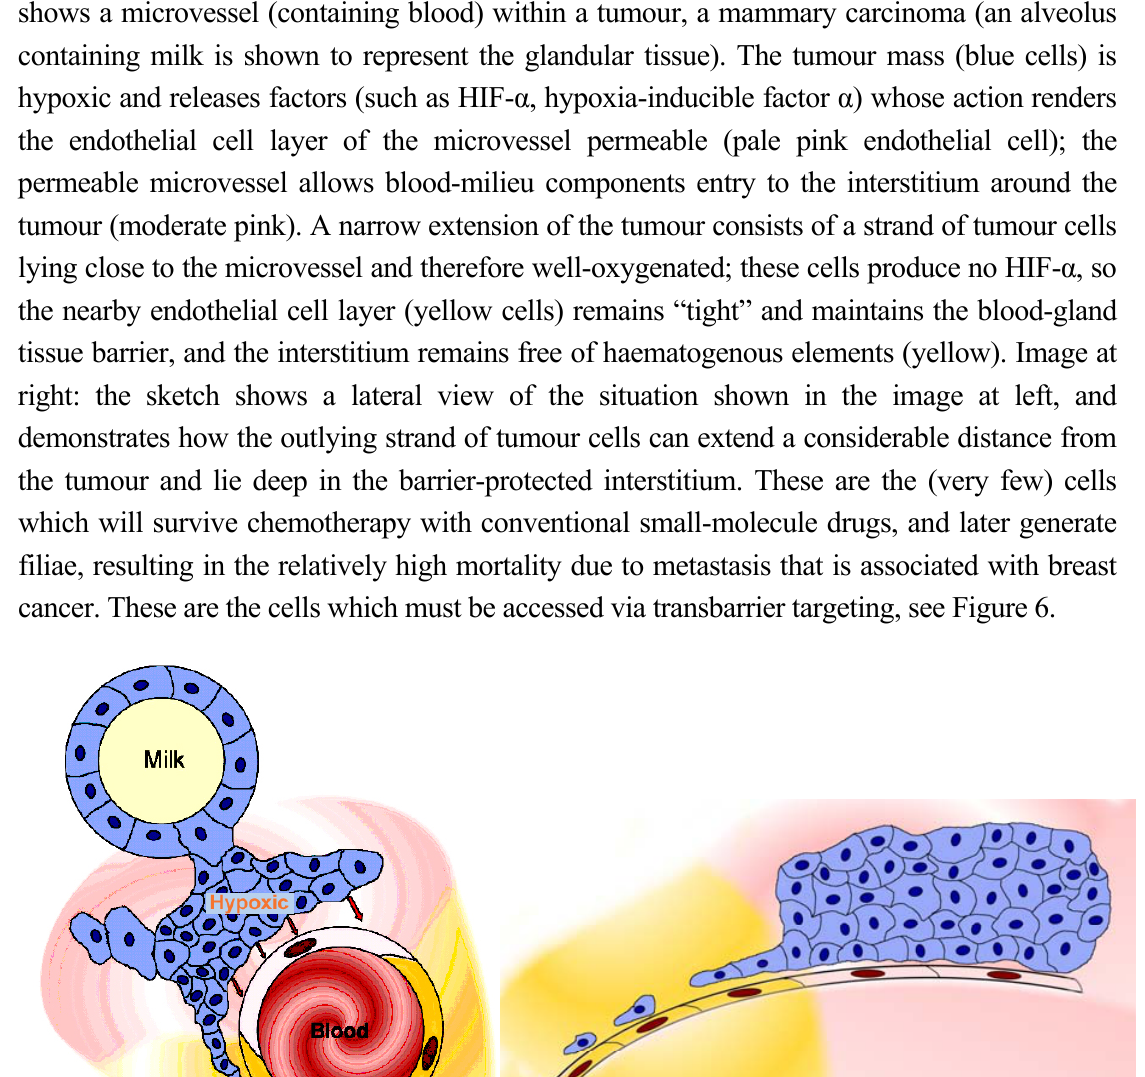
permeable microvessel allows blood-milieu components entry to the interstitium around the tumour (moderate pink). A narrow extension of the tumour consists of a strand of tumour cells lying close to the microvessel and therefore well-oxygenated; these cells produce no HIF- α , so the nearby endothelial cell layer (yellow cells) remains “tight” and maintains the blood-gland tissue barrier, and the interstitium remains free of haematogenous elements (yellow). Image at right: the sketch shows a lateral view of the situation shown in the image at left, and